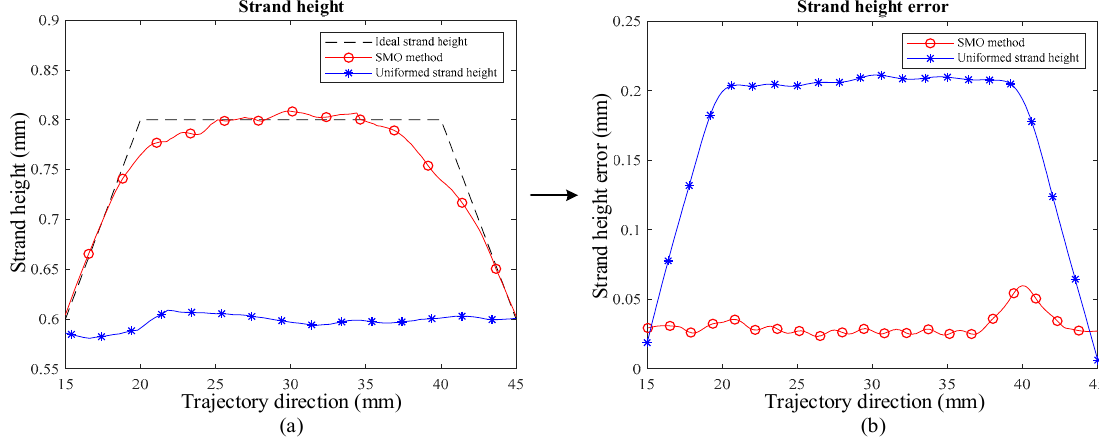
Figure 11. Strand height and strand height error distribution. ( a ) Strand height distribution along the trajectory, where the red curve with circles is the distribution of strand height along the trajectory direction for specimens made using the SMO method, and the blue curve with asterisks is the distribution of strand height along the trajectory direction for specimens made using the uniform strand height; ( b ) strand height error distribution along the trajectory, where the red curve with circles is the distribution of strand height error along the trajectory direction for specimens made using the SMO method, and the blue curve with asterisks is the distribution of strand height error along the trajectory direction for specimens made using the uniform strand height method.